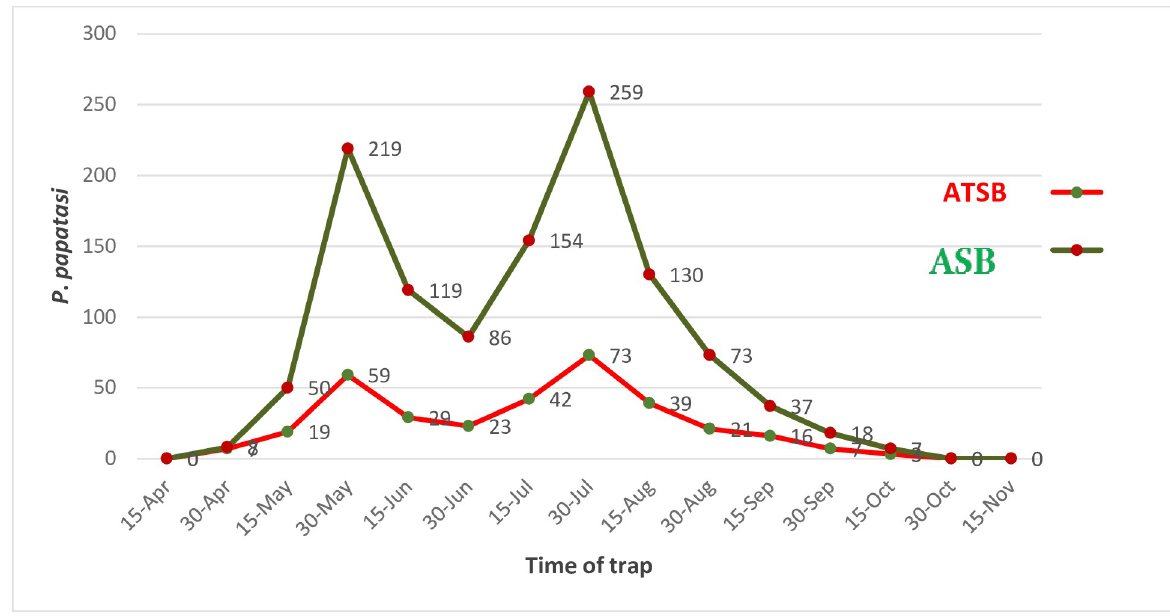
Fig 3. Number of P. papatasi sand fly collected from treated barrier fences in Markazi District, Qom province, 2015, Iran. -Exposed to ATSB, -exposed to ASB.